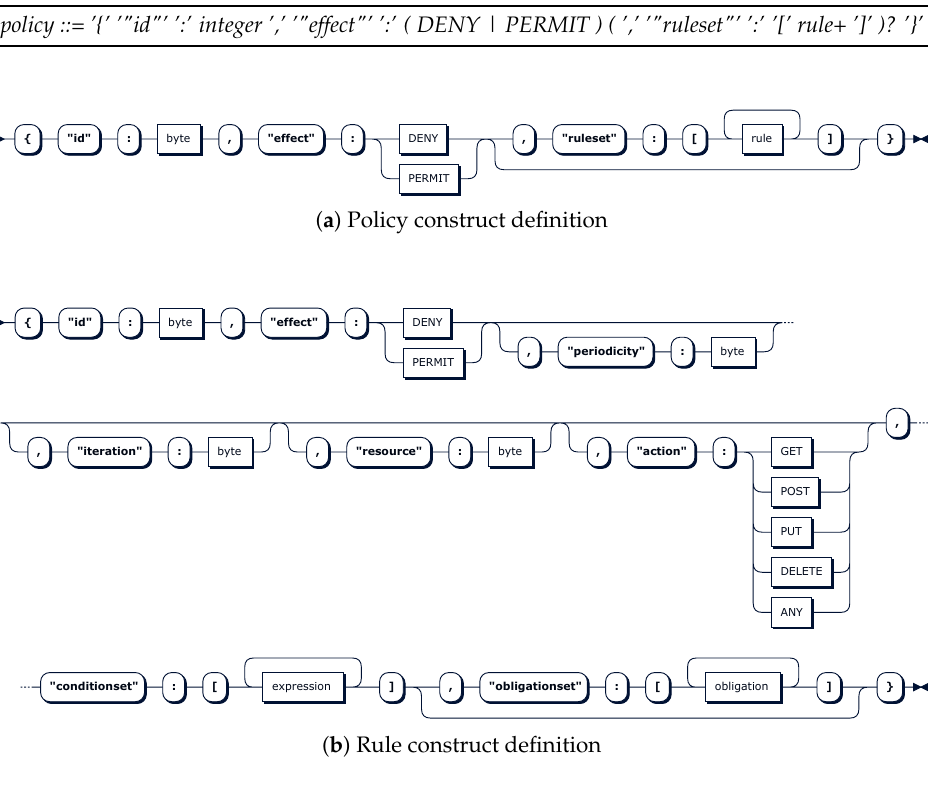
Figure 3. Policy language main